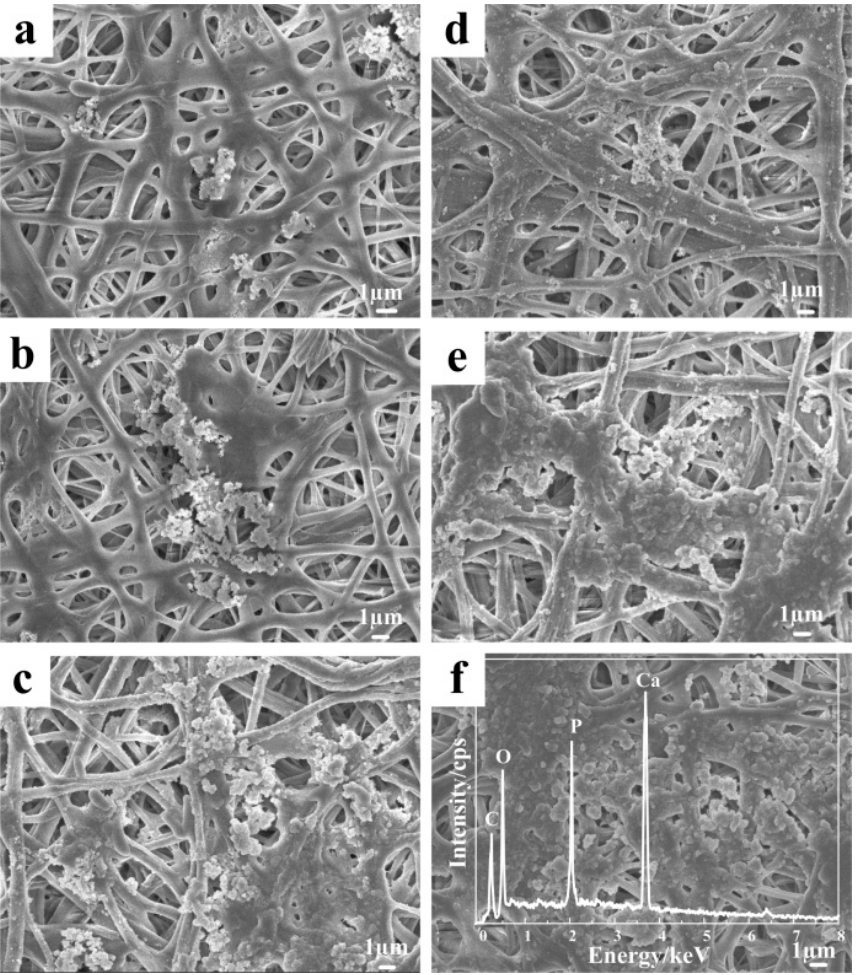
Figure 7. SEM images of the water-treated CA nanofibers after incubation for various days ( a ) 3 days, ( b ) 6 days, and ( c ) 9 days. Water-treated CA/5% PVP fibers after incubation for various days ( d ) 3 day, ( e ) 6 days, and ( f ) 9 days with EDS spectrum.